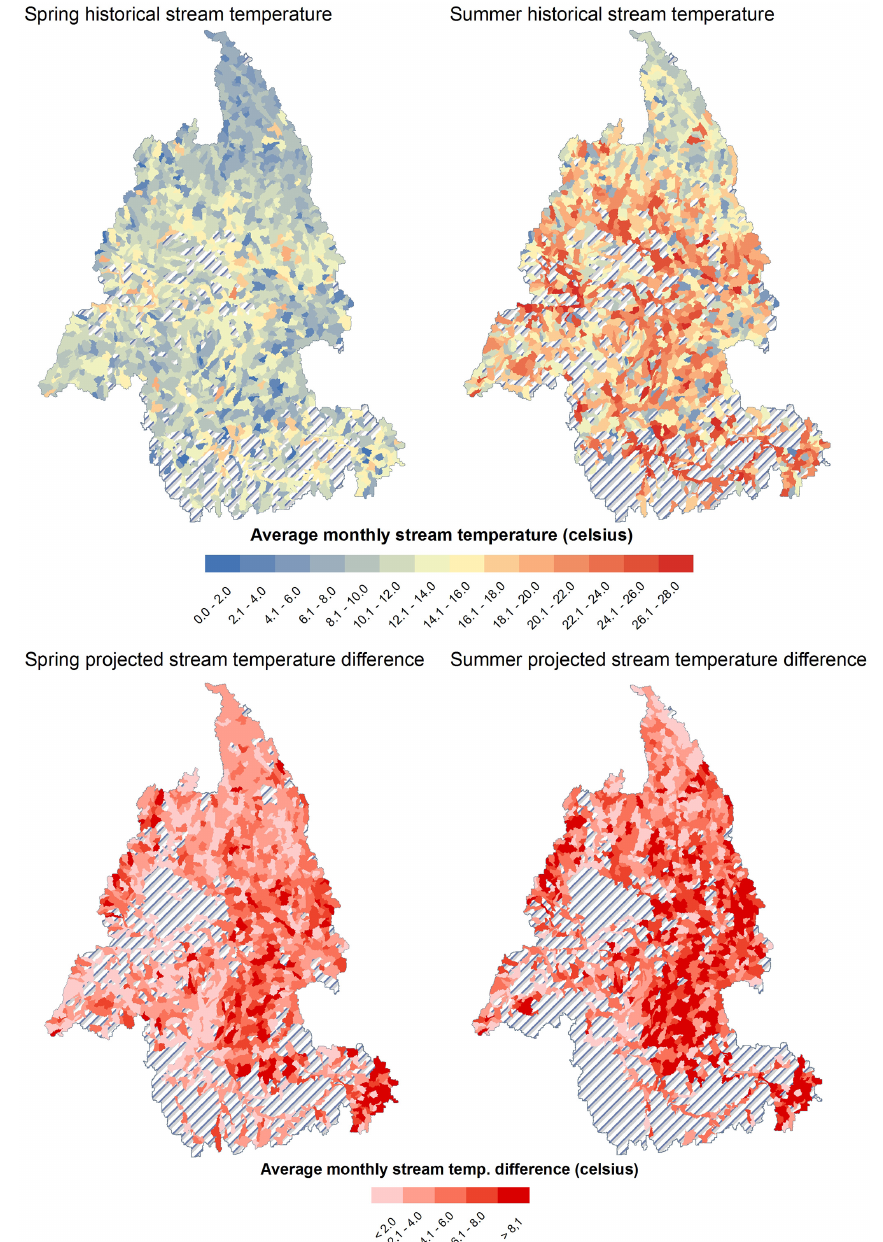
Figure 5. Spring and summer historical and projected stream temperatures at the subbasin level. Hatched subbasins indicate that drying occurred under climate projections and were removed from